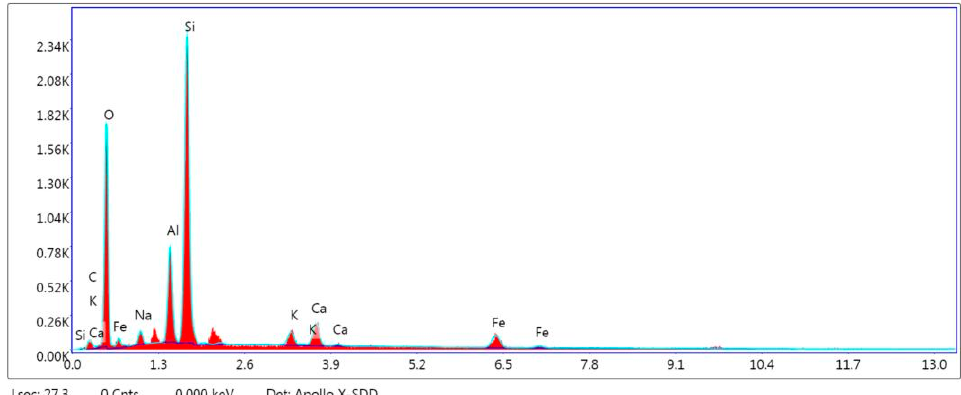
Figure 15. Energy spectrum of each element in D-3 soil sample energy spectrum area.